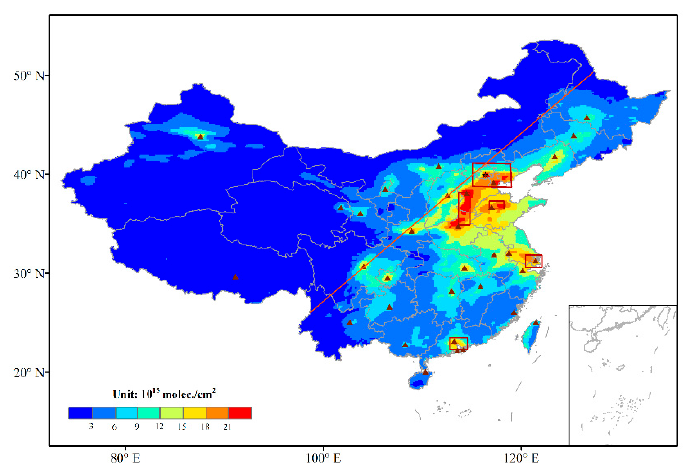
Figure 1. The spatial distribution of the average 14-year tropospheric NO 2 vertical column density (VCD) from 2005 to 2018 (unit: 10 15 molec cm − 2 ). The red boxes denote the five hotspots we selected. From north to south, these hotspots are Beijing–Tianjin–Tangshan, South of Hebei and North of Henan combined, Jinan, Yangtze River Delta and Pearl River Delta. Triangles indicate the mean capital city of each province. The red line denotes the Heihe–Tengchong line (Hu Huaiyong line).